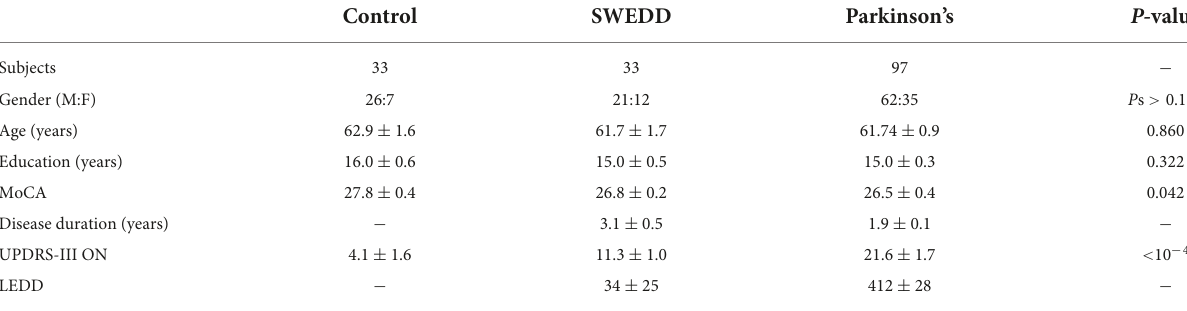
TABLE 1 Demographic information for the groups used in this analysis.